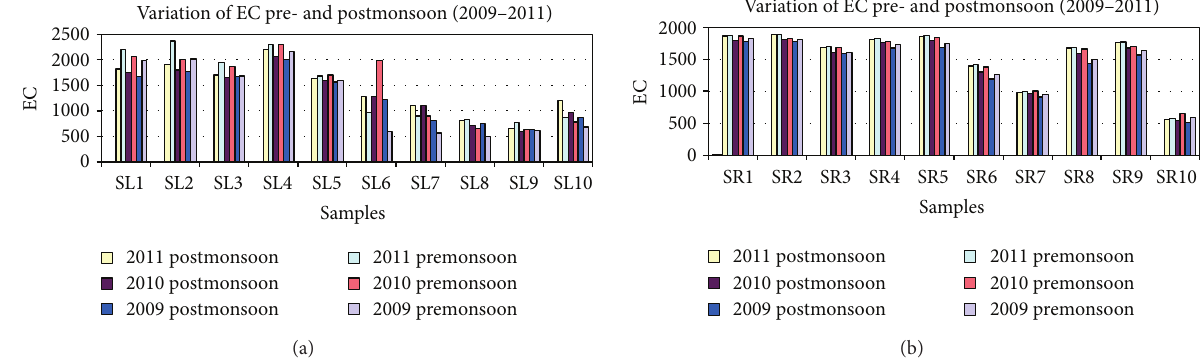
Figure 3: (a) Observations of EC in water from the sites SL1–SL10 for the pre- and postmonsoon of 2009–2011. (b) Observations of EC in water from the sites SR1–SR10 for the pre- and postmonsoon of 2009–2011.